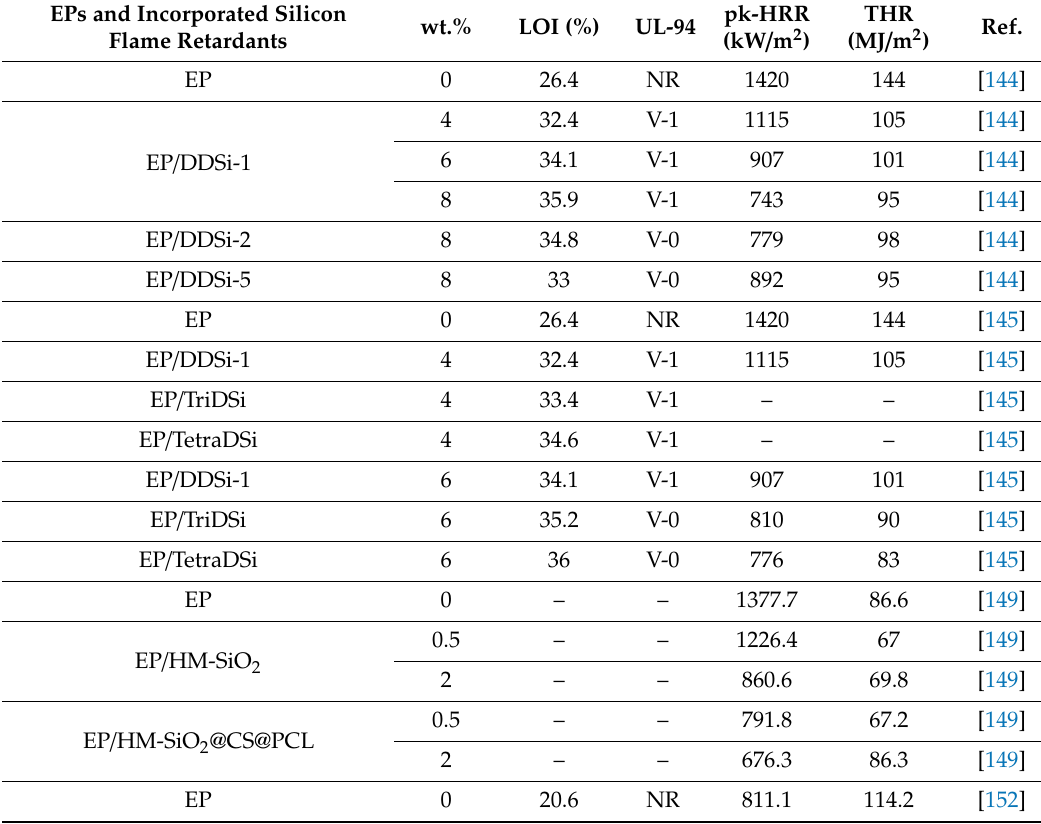
Table 4. The flame retardancy performance of epoxy containing silicon flame retardants. EPs and Incorporated Silicon Flame Retardants